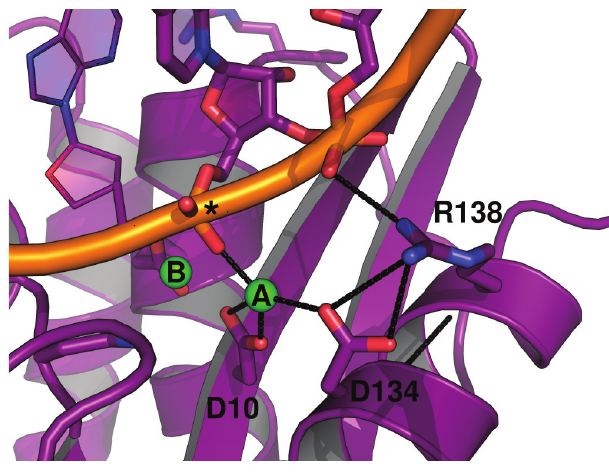
Figure 7. Hydrogen-bonding environment of the A site of hsRNH in complex with substrate. Interactions between D134, R138, metal ion A, and the phosphate backbone of the RNA strand are shown (PDB ID 2QKK). An asterisk indicates the scissile phosphate. The preorganization of the R138-D134 salt bridge in the apo state of ecRNH likely minimizes the entropic cost of forming this interaction upon substrate